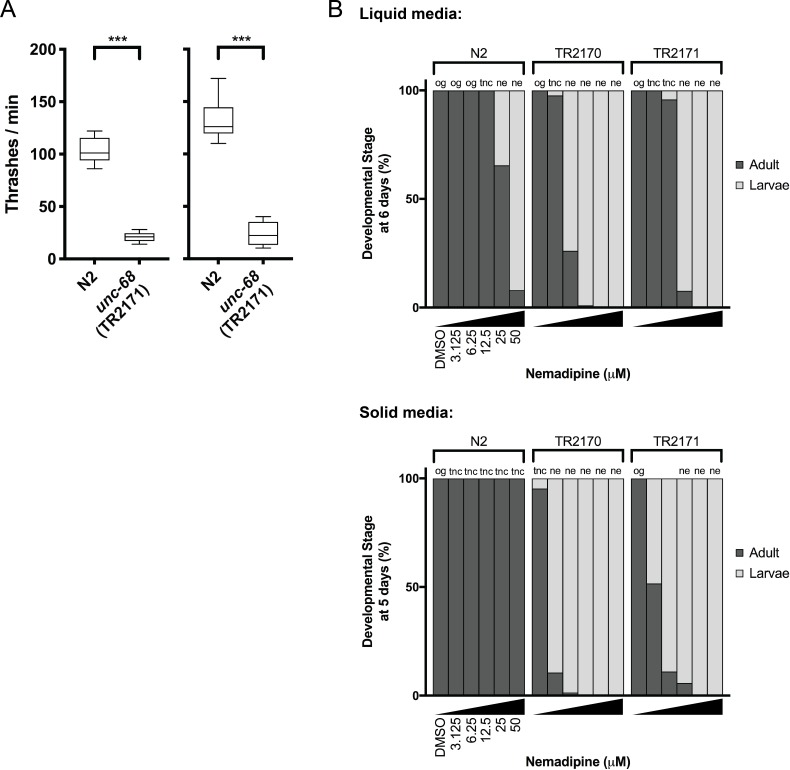
Phenotypes of unc-68 mutants considered for chemical screening.(A) The ‘thrashing assay’ is performed by counting the waveforms propagated by individual C. elegans in one minute (Maryon et al., 1996). Consistent with previous reports (Maryon et al., 1996; Maryon et al., 1998), we found that unc-68 mutants thrash at a significantly lower rate than N2 (wild type) in two independent assays (n = 10 per genotype; Student’s T-test: ***p<0.001). (B) In both liquid and solid media, the DHPR inhibitor nemadipine-A (Kwok et al., 2006) induces concentration-dependent developmental growth arrest in unc-68(r1161) (strain TR2170) and unc-68(r1162) (strain TR2171) mutants. L1 larvae were plated in chemical at Day 0 (n = 20/well liquid 96-well plate; n = 50/well solid 24-well plate) and developmental stage was measured at Day 6 (liquid) and Day 5 (solid). Abbreviations: og = overgrown with larvae/eggs and food source depleted; tnc = larvae and eggs were too numerous to count, but food source not depleted; ne: no eggs have been laid (this phenotype is consistent with inhibition of egg-laying defective protein EGL-19, a DHPR, by nemadipine-A).